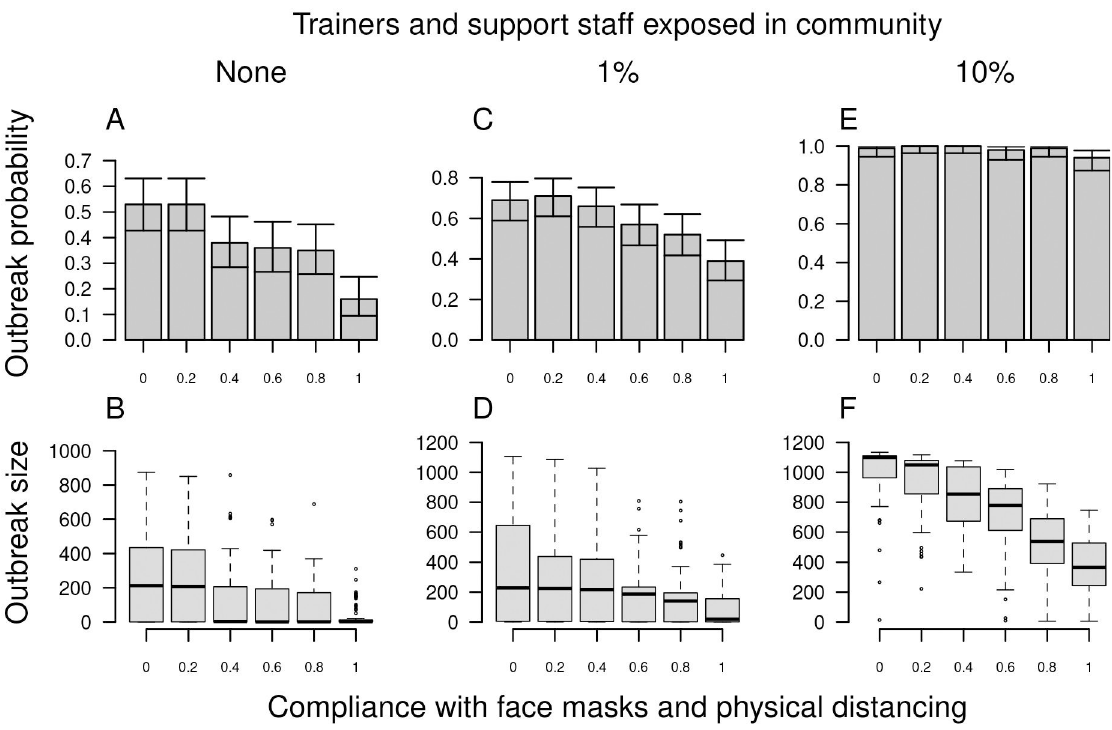
Fig 6. Outbreak probability (top) and size (bottom) in basic training as a function of compliance with face masks and physical distancing (x-axis). From left to right, columns show increases from 0 to 0.01 to 0.10 of the probability that trainers and support staff were exposed to the virus in the community over the course of the 70-day training period. Error bars for outbreak probability indicate 95% Pearson-Clopper confidence intervals.